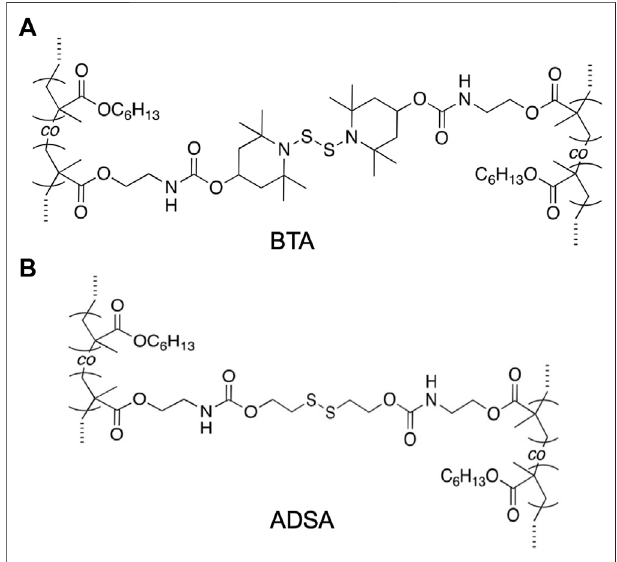
FIGURE 2 | Disul fi de-containing crosslinks in polymethacrylate networks proposed in Ref. Takahashi et al. (2017a). (A) : BiTEMPS-containing diacrylate (BTA); (B) : dialkyl disul fi de-containing diacrylate